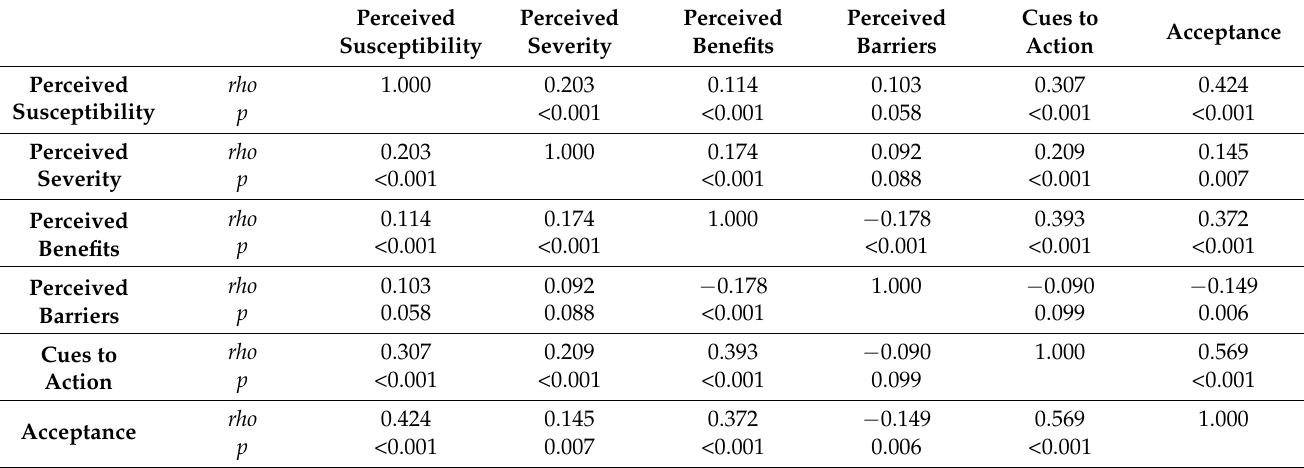
Table 7. Correlation between HMPXV vaccine perceptions and acceptance of Czech HCWs respond- ing to the HMPXV survey, September 2022 ( n = 341).